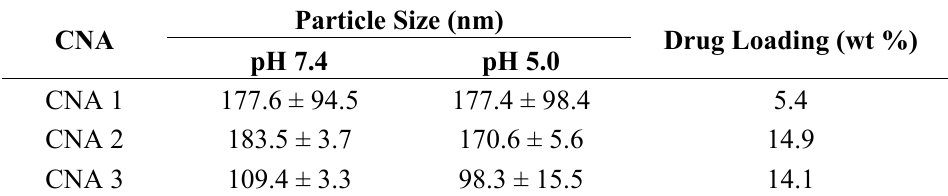
Table 1. Characterization of CNAs entrapping 17-AAG.